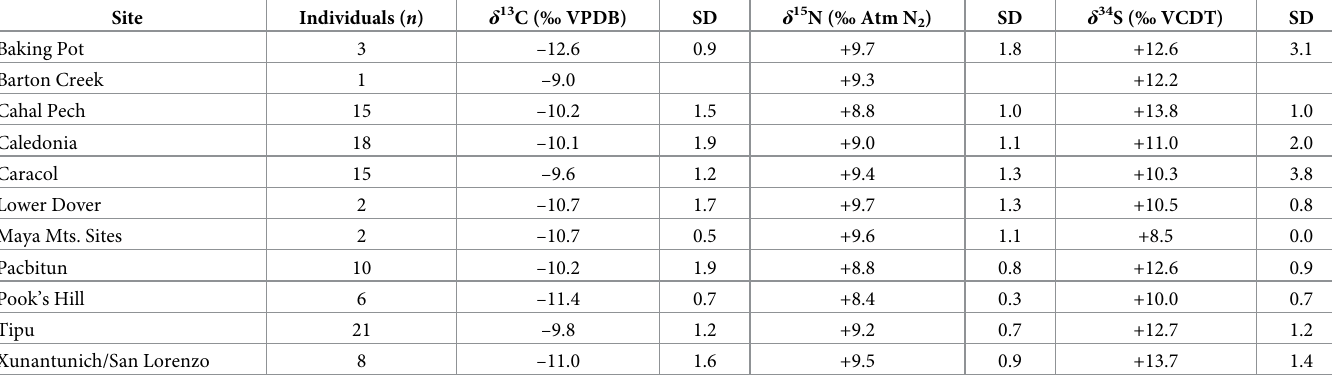
Table 3. Mean δ 13 C, δ 15 N, and δ 34 S values by site for Eastern Maya lowlands.